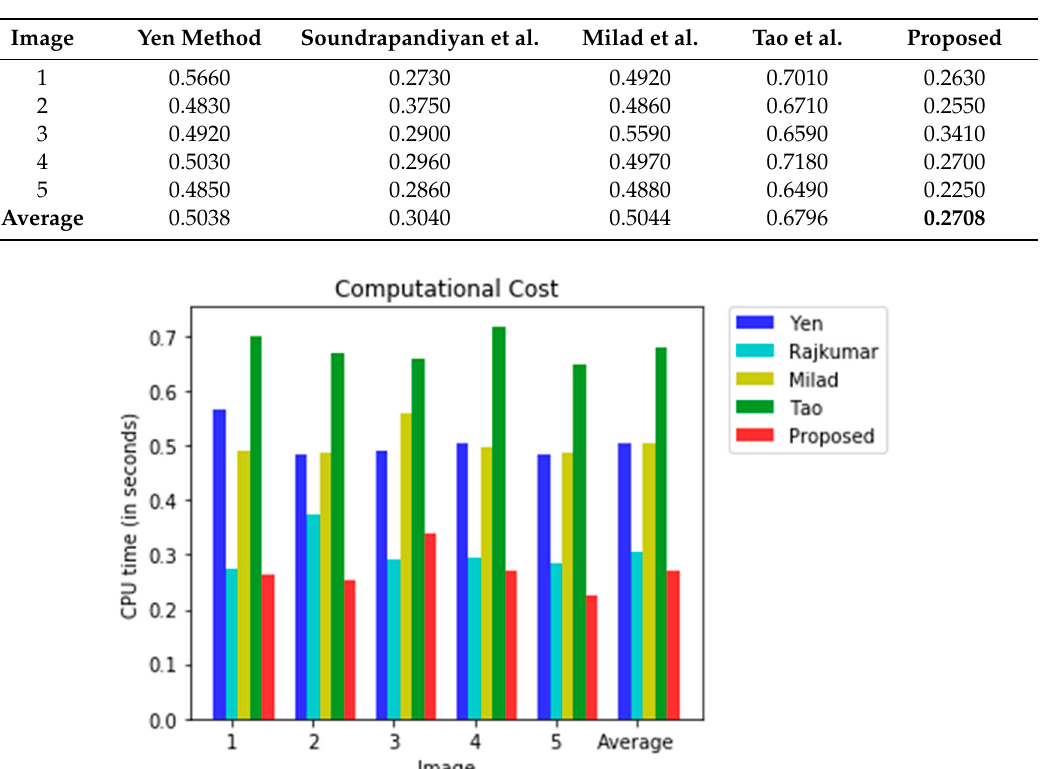
Table 4. Computational cost (in seconds) results for the five methods.